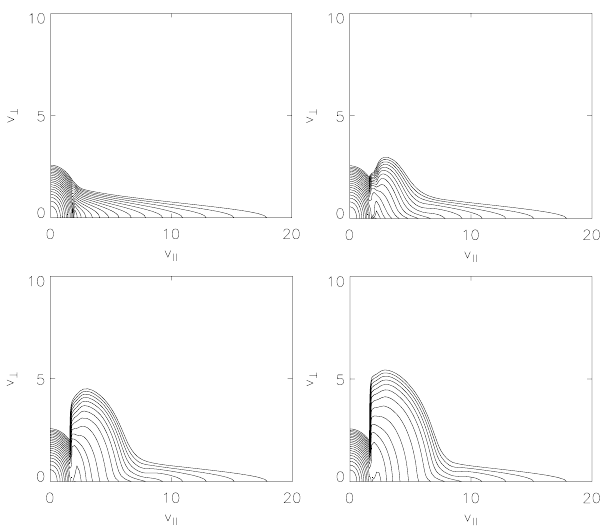
. The wave num- ω ce